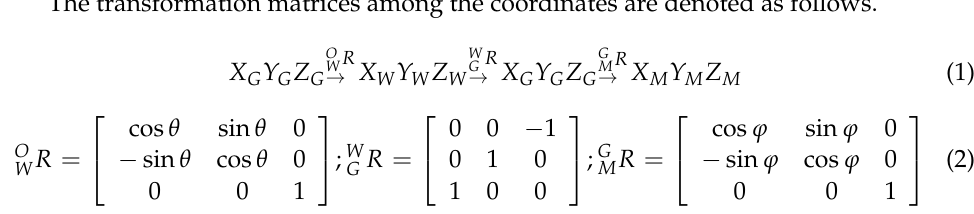
Later, the human hand is considered as a linear ruler with a mass m W , location of center of gravity (CoG), and angular velocity of hand in X W Y W Z W . A coordinate is computed according to the equations below, where K W , D W , T pert denote the stiffness coefficient, W damping ratio, and moment due to the oscillation acting on the hand, respectively.